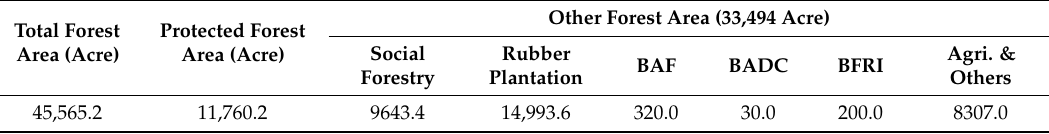
Table 1. Different land-use categories of the